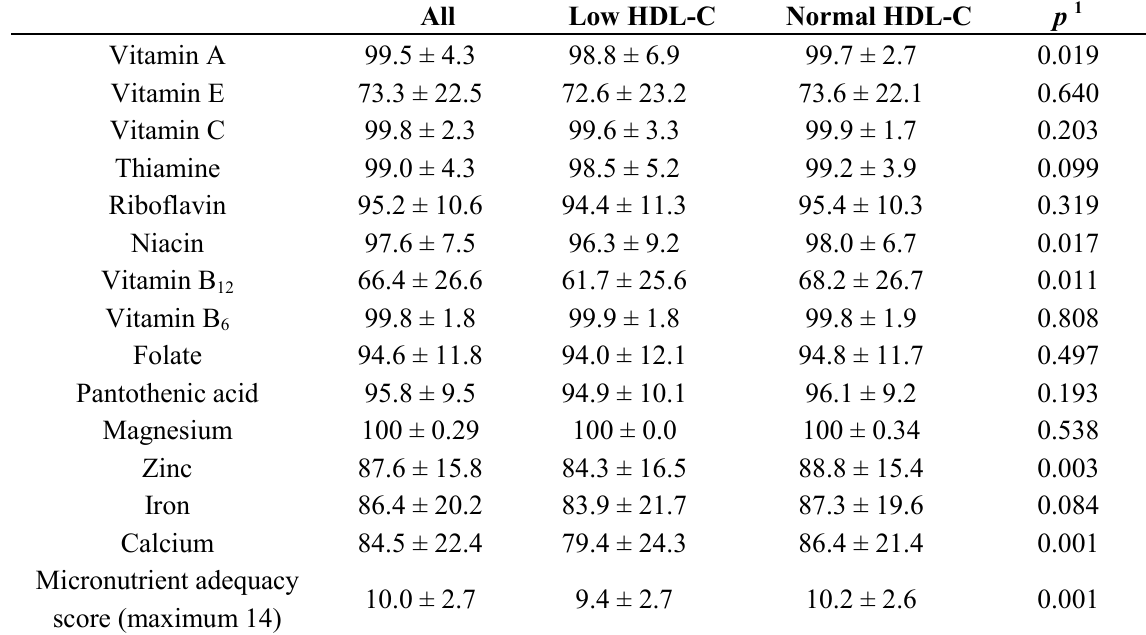
Table 4. Micronutrient intake adequacy % according to HDL-C level.